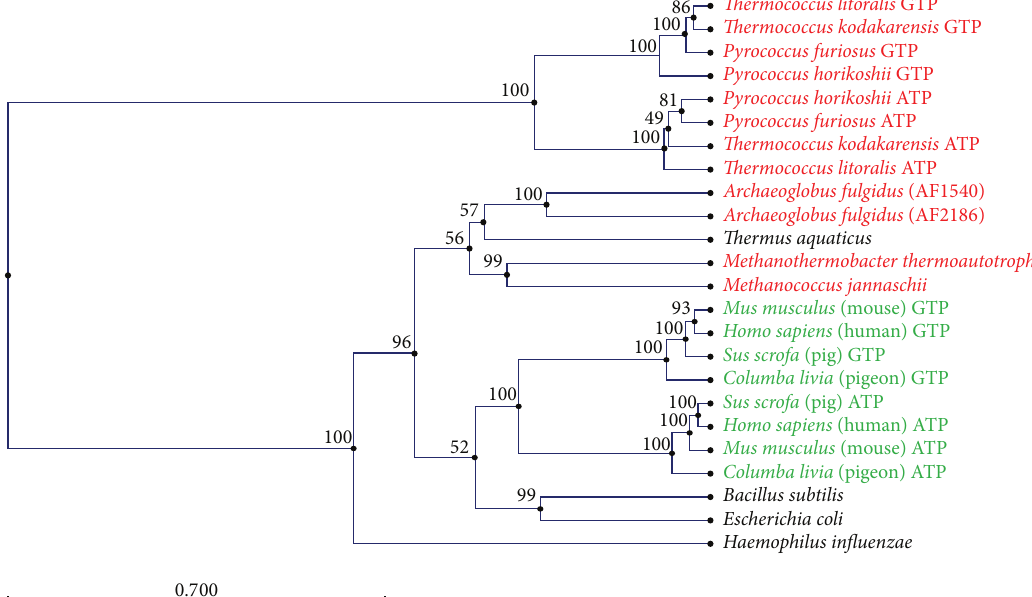
Figure 4: Phylogenetic tree of ACS 𝛽 subunits. The unweighted pair group method of arithmetic mean (UPGMA) tree is shown. A neighbor- joining tree (data not shown) also shows similar relationships for the vertebrate and Thermococcales subunits with a few changes for the remaining species. Archaea are highlighted red, Bacteria are in black and Eukarya in green. Tree and Bootstrap values were generated using CLC Main Work Bench 6 with 100